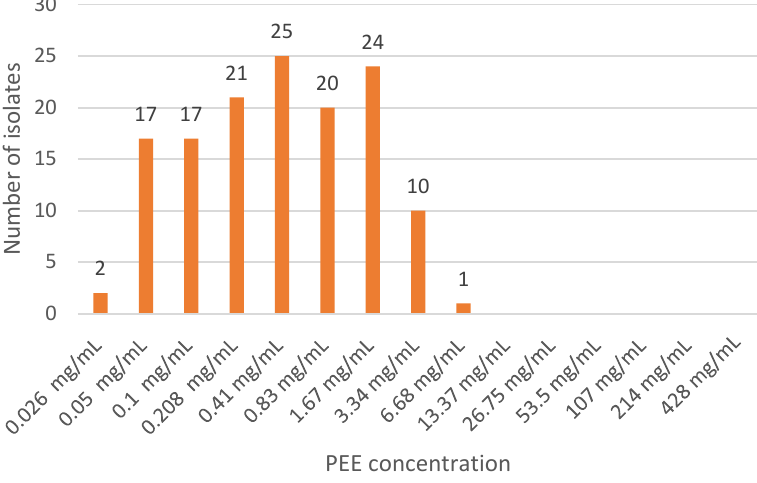
Figure 1. PEE minimum bactericidal concentration against 137 staphylococci field isolates. The susceptibility of the different Staphylococcus species (including field isolates and control strains) to the propolis ethanolic extract is given in Table 2. Table 2. Susceptibility to PEE of the different Staphylococcus species.